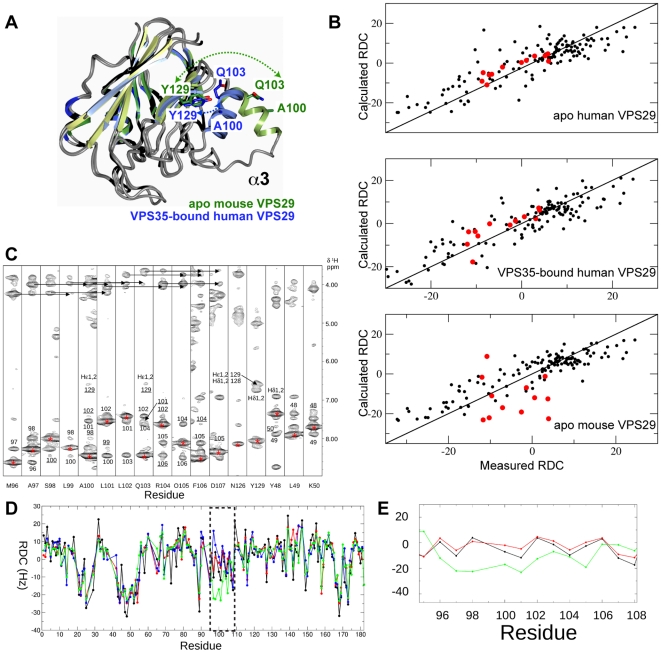
The α3 helix of VPS29 adopts a compact conformation in solution.(A) Comparison of previous VPS29 crystal structures reveals differences in the orientations of the α3 helix. VPS29 adopts an extended α3 orientation in the mouse apo VPS29 crystal structure (PDB 1Z2X; green), and a compact orientation in the VPS35-bound human VPS29 structure (PDB 2R17; blue). Ala100, Gln103 and Tyr129 are shown for each structure, to show residues for which long-range NOEs are observed. In the apo mouse VPS29 structure these residues would be too far apart to observe these NOE contacts. (B) RDC correlation plots indicate the apo mouse VPS29 protein adopts a compact structure in solution, where the α3 helix is similar to the VPS35-bound conformation, but not the previous mouse VPS29 crystal structure. Shown are 133 1DHN RDCs fitted to the apo human VPS29 structure (PDB 1W24), human VPS29 in complex with VPS35 (PDB 2R17) and the mouse VPS29 structure (PDB 1Z2X). The residues of helix α3 are highlighted in red (95–107). Residue 99 was not included due to severe overlap in the 2D 15N IPAP spectra. Single value decomposition analysis of the HN-N RDCs to the apo human, VPS35-bound human or apo mouse X-ray structures yielded the following: The largest component of the alignment tensor (Szz) were 1.31e−3, 1.35e−3, 1.09e−3 and Rhombicities (Syy−Sxy/Szz) were 0.53, 0.53 and 0.48. (C) 2D 1HN-1H strips from the 3D 15N NOESY-HSQC show the NOE connectivities along helix α3 (residues 97–107). Diagonal peaks for each strip are labelled with an asterisk and proximal protons that give rise to observable NOEs are annotated. Medium range i, i+2 1HN-1HN NOES are underlined while medium range i, i+3 and i, i+4 1Hα-1HN NOES are identified with arrows. Both are diagnostic of a regular alpha helix. Two long range NOEs to the Hε protons of Tyr129 from the 1HN of Ala100 and Gln103 are labelled as well as the long-range (cross sheet) 1HN-1HN NOE between Y129 and F122. (D) 1DHN RDCs observed (black) compared to those calculated for each residue for mouse VPS29 structure (PDB 1Z2X, green), apo human VPS29 structure (PDB 1W24, red) and human VPS29 in complex with VPS35 (PDB 2R17, blue). (E) Detail comparing the close fit of the 1DHN RDCs to the α3 orientation in the apo human VPS29 compared to the poor fit to the mouse α3 orientation.